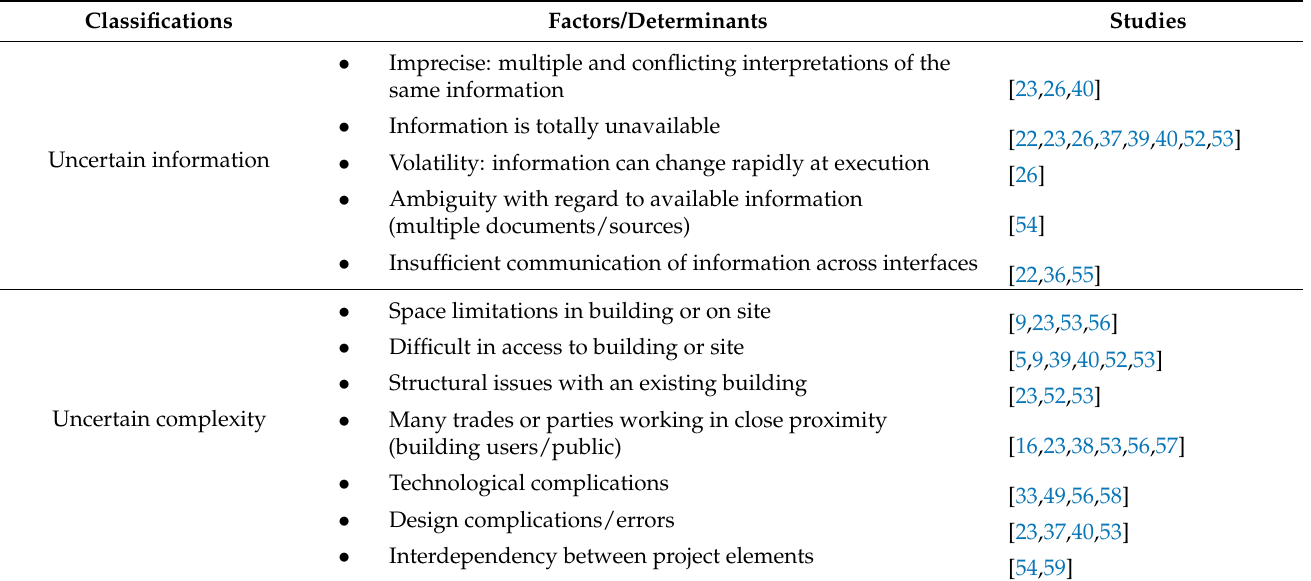
Table 1. Uncertainty factor